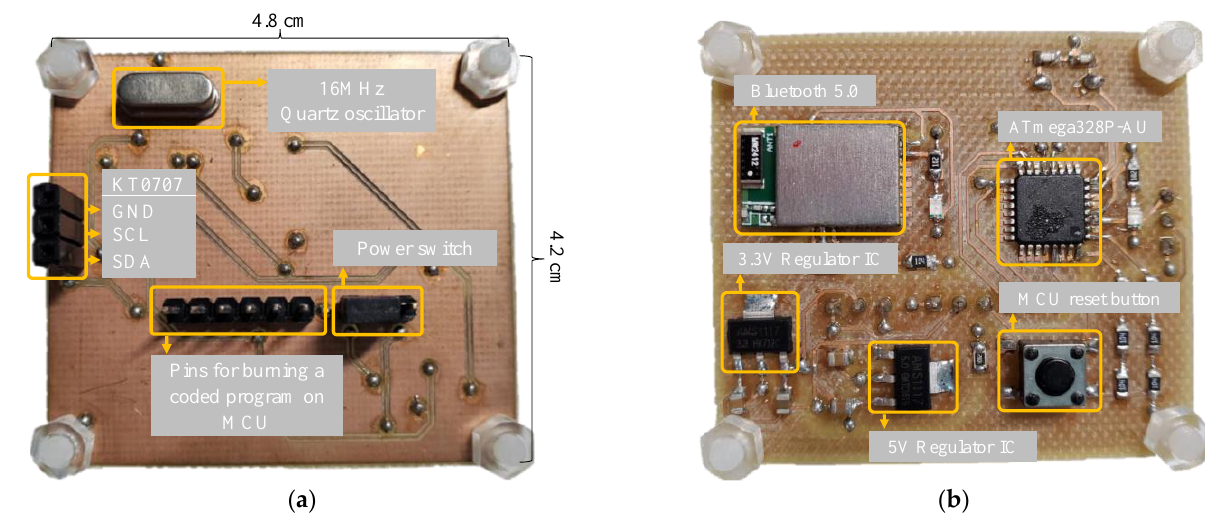
Figure 2. Proposed DTC circuit placement and layout design: ( a ) button view and ( b ) top view.